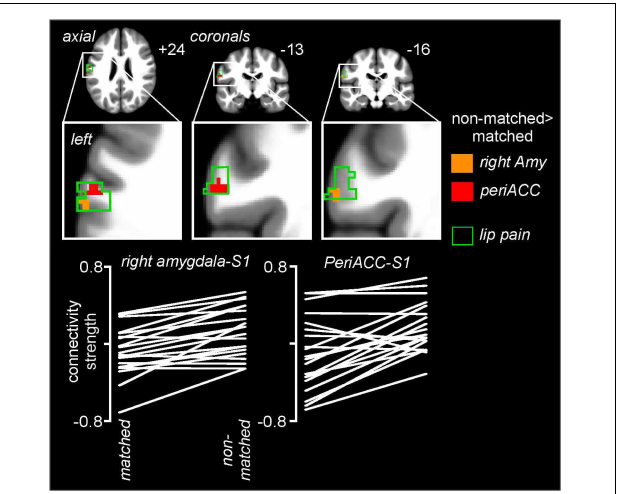
FIGURE 6 | Noxious stimulus related connectivity differences during non-matched compared with matched expectation scans between the left primary somatosensory cortex (S1) and the right amygdala (Amy) and perigenual anterior congulate cortex (periACC) clusters. Greater S1 connectivity during non-matched trials occurred with both the right amygdala (orange shading) and perigenual ACC (red shading). The green outline indicates areas of the left S1 in which signal intensity increases during noxious thermal stimuli occurred during the baseline trial. Slice locations in Montreal Neurological Institute space are indicated at the top right of each image. The lower row are plots of connectivity strengths for the right amygdala-S1 and periACC-S1 for each subject during matched and non-matched expectation